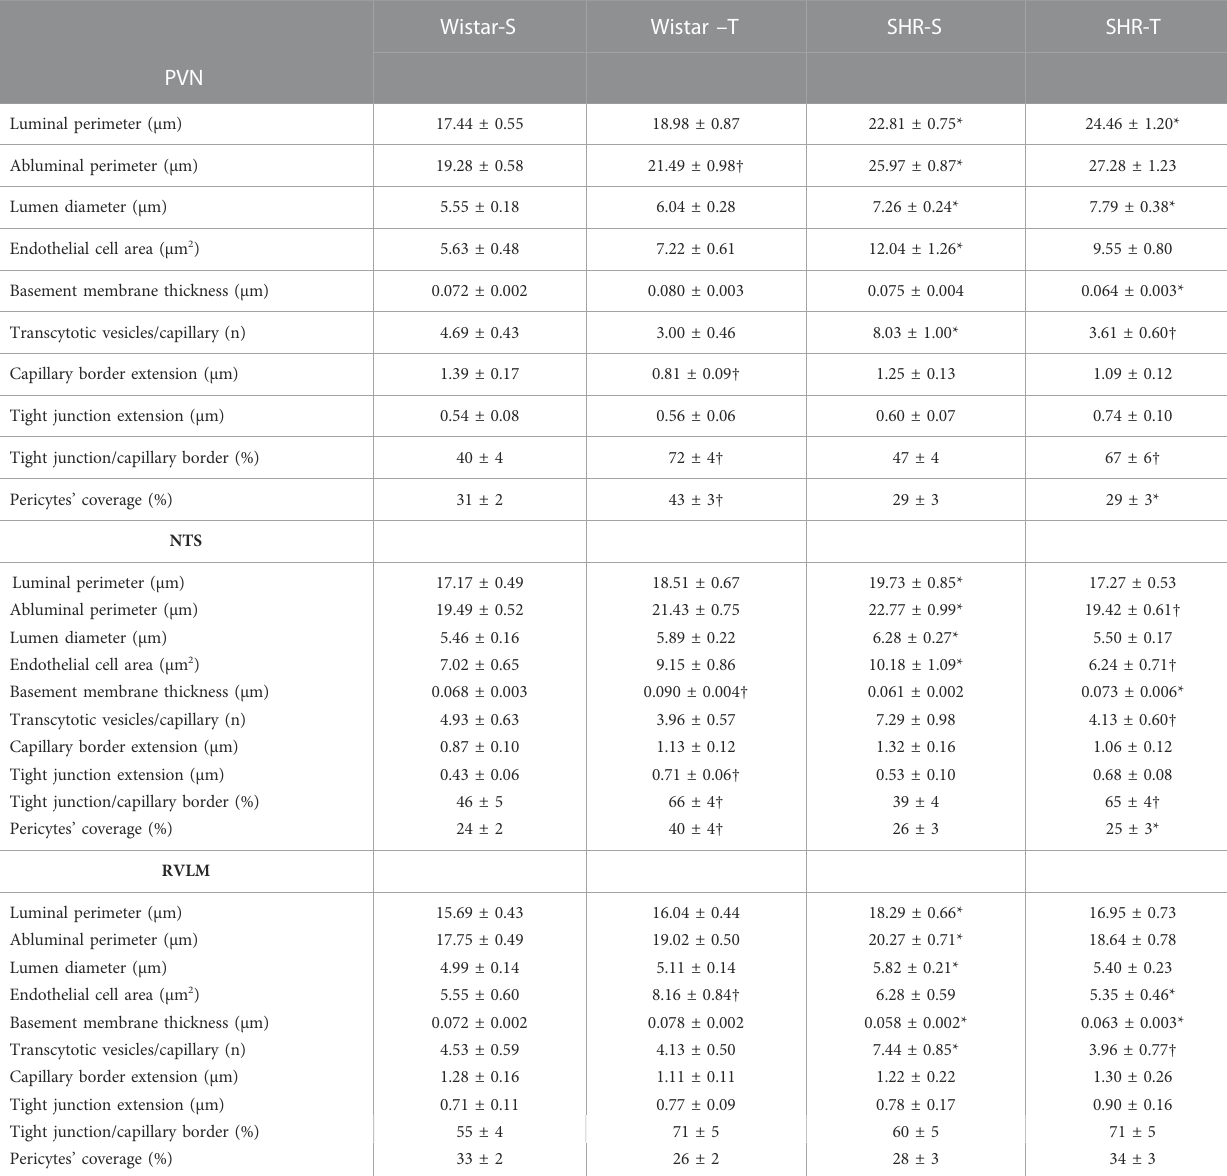
TABLE 2 Quantitative data of PVN, NTS, and RVLM capillaries ’ ultrastructure in the 4 experimental